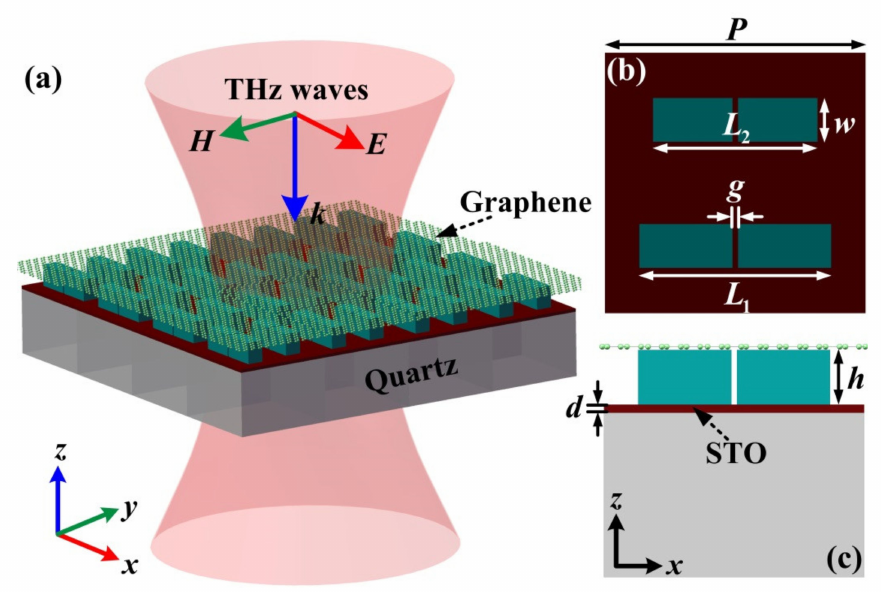
Figure 1. ( a ) Schematic view of the proposed metasurface structure, which is integrated with the strontium titanate (STO) film and the graphene monolayer. ( b , c ) Top and y–z cross-section view and geometric parameters of the unit cell